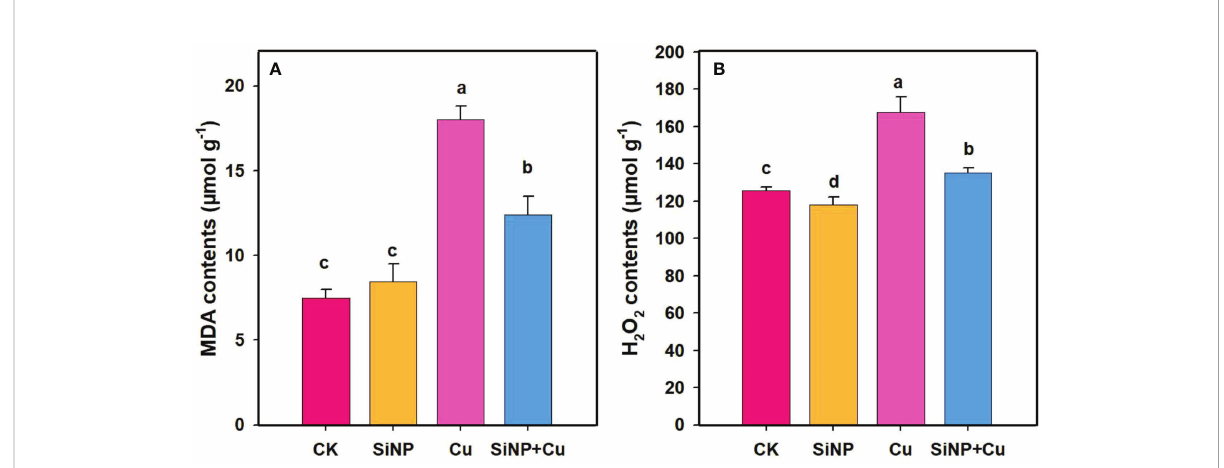
FIGURE 4 MDA and H 2 O 2 contents of wheat roots under Cu 2+ stress. Note “ Experimental treatments contained: CK (control); SiNP (2.5 mM SiNPs); Cu (500 µM Cu 2+ alone), SiNP+Cu (2.5 mM SiNPs+500 µM Cu 2+ ). The different letters (a, b, c, d) describe the differences in different treatments by LSD test at (P ≤ 0.05) ” . (A) MDA contents, (B) H2O2